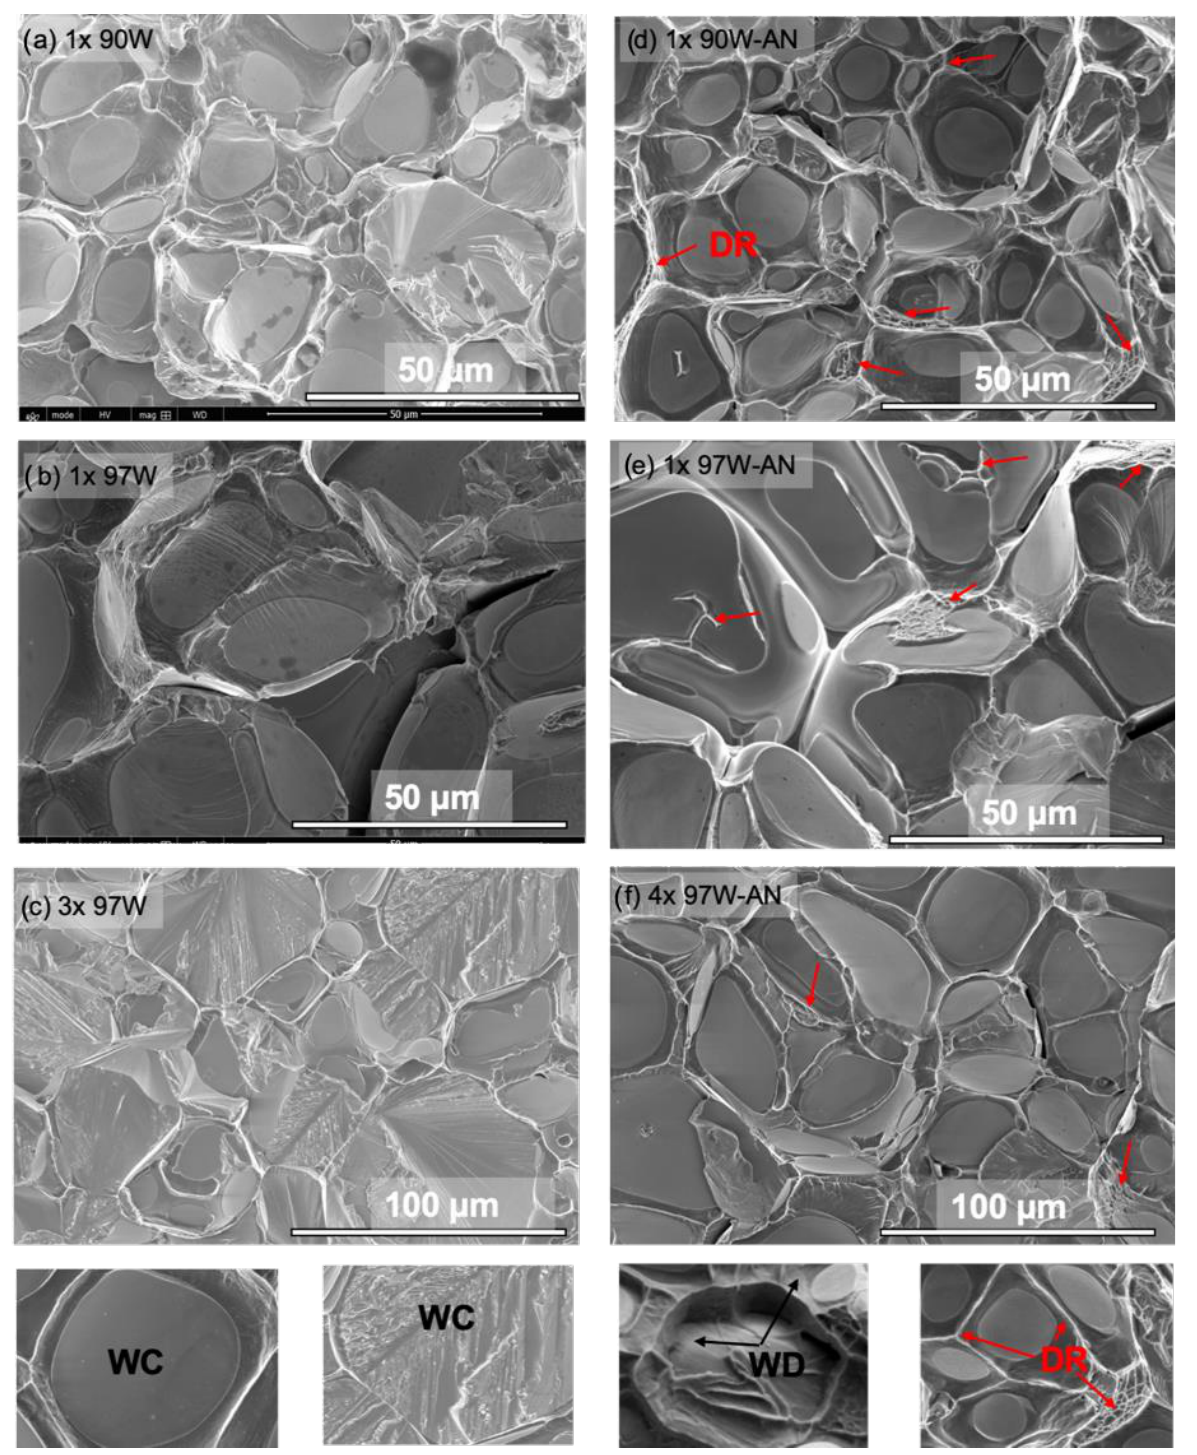
Figure 10. SEM micrographs of fracture surfaces: ( a ) AS 1× 90W; ( b ) AS 1× 97W; ( c ) AS 3× 97W; ( d ) AN 1× 90W; ( e ) AN 1× 97W; ( f ) AN 4× 97W. The bottom row illustrates the nature of local fracture d ) AN 1 × 90W; ( e ) AN 1 × 97W; ( f ) AN 4 × 97W. The bottom row illustrates the nature of local modes. ( fracture